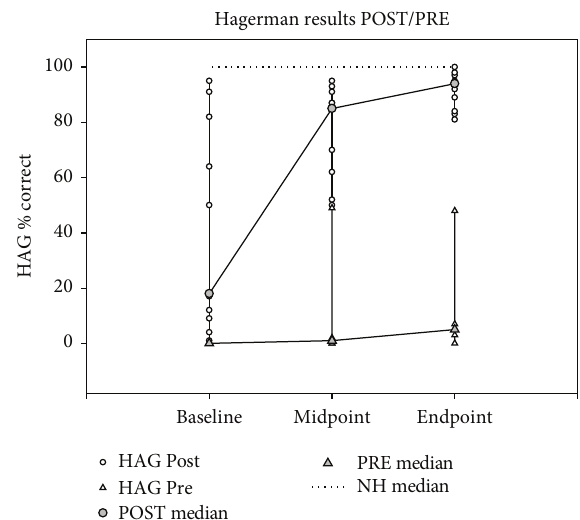
Figure 4: Mixed line and scatter plot showing individual and median Hagerman speech perception scores for the POST and the PRE subgroups at the three milestones. The dotted line represents the median score of the NH reference